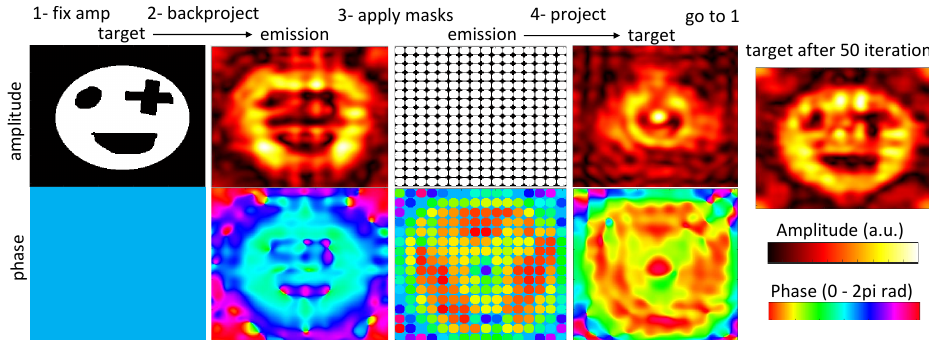
Figure 6. Iterative algorithm to determine the emission phases and amplitudes for an array of emitters. Step (1) fix the amplitude into the target slice, the phase is not modified. Step (2) Backproject the target into the emission. Step (3) Apply on the emission slice a discretization on phase, amplitude, and spatial resolution, as well as the mask with the shape of the emitters. Step (4) Project the emission into the target. After 50 iterations of steps 1 to 4, the target amplitude is shown at the left.